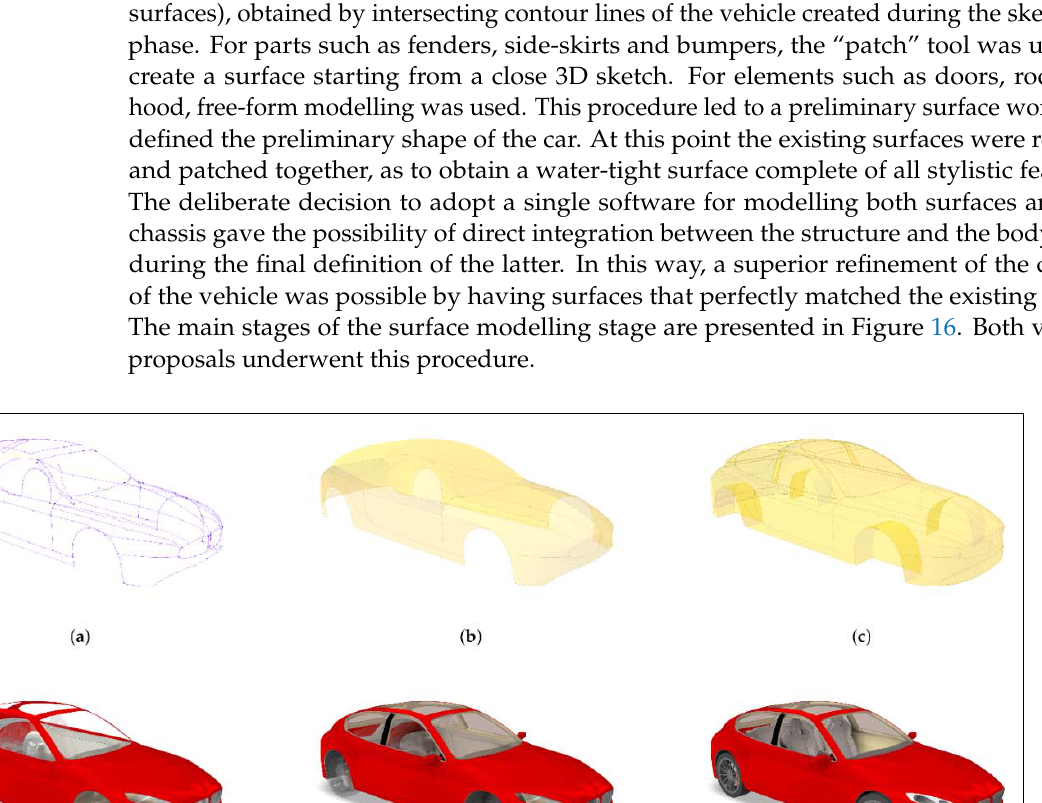
Figure 15. FEM simulation of the chassis. From the left: static, flexural and torsional test.